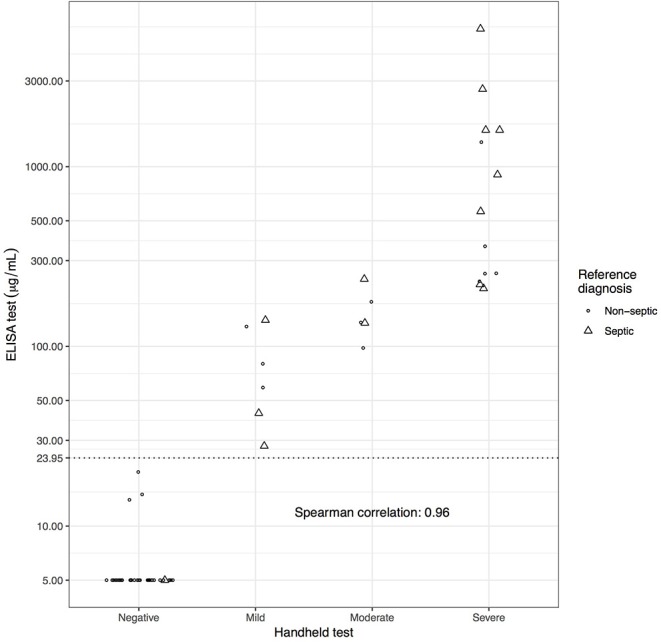
Scatterplot of ELISA SAA values vs. handheld test results with point shape representing reference diagnosis (Septic (S) synovial structures = triangles and non-septic (NS) synovial structures = circles). Points are spread horizontally where ELISA results are similar). ELISA cutoff (23.95) maximizing the sum of Se and Sp is shown as an additional labeled gridline. The Spearman rank correlation between ELISA score and ordinal handheld test score is also shown.